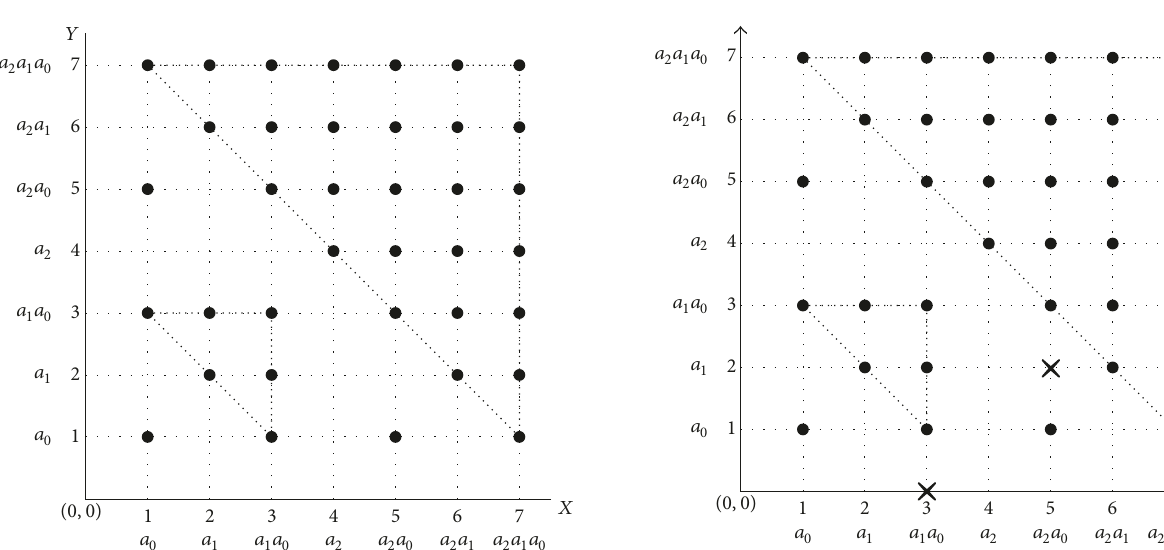
Figure 1: Pandit-Plot (for 𝑛 = 3 ) with redundant data-points. Figure 2: Pandit-Plot for